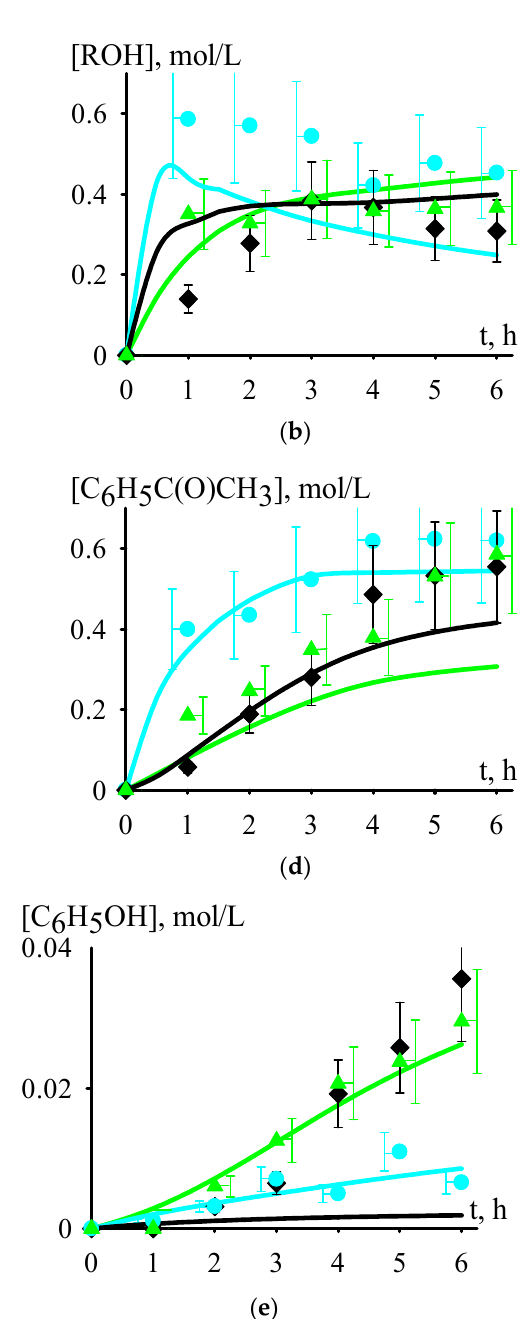
Figure 2. The dependencies of the component concentrations of the reaction mixture in cumene hy- droperoxide decomposition versus time: dots are the experimental data, and lines are the calculation by the model; ( a ) ROOH; ( b ) ROH; ( c ) C 6 H 5 C(CH 3 ) = CH 2 ; ( d ) C 6 H 5 C(O)CH 3 ; ( e ) C 6 H 5 OH.